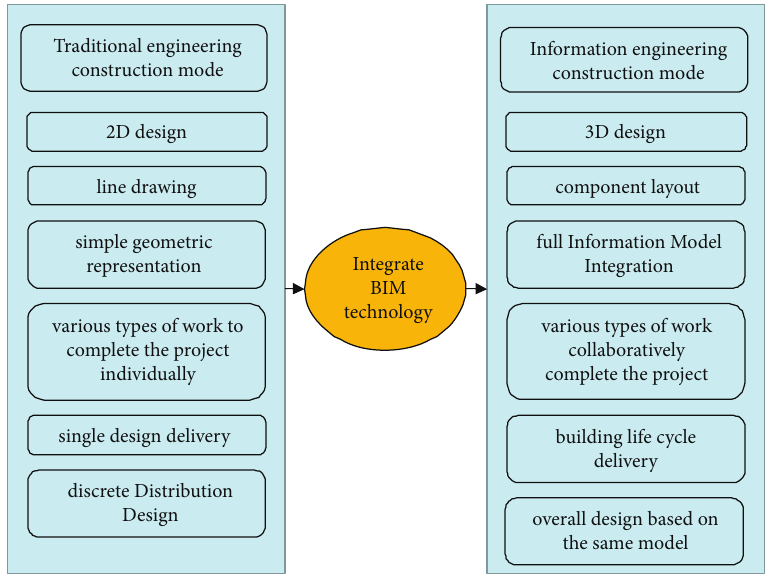
Figure 3: Changes brought by BIM in engineering